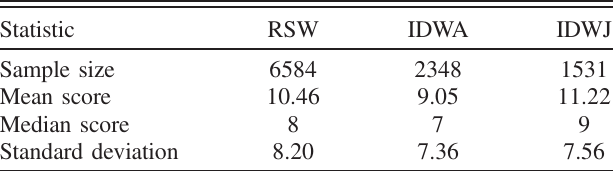
TABLE I. Descriptive statistics for all three datasets: our data (RSW), the American data from IDW (IDWA), and the Japanese data from IDW